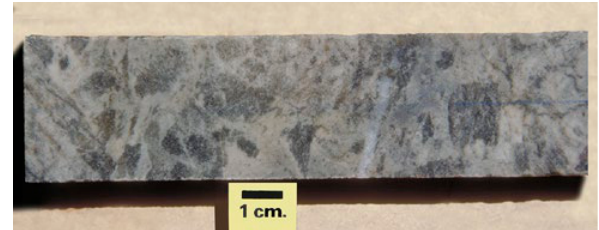
Figure 37. An intrusive siliceous breccia of grey chert contai- ning angular and partly digested fragments of chloritic wall-rock was intersected in drilling near the margins of the gold orebody at the Peak Mine in Cobar, NSW. These earlier grey cherty ‘elvans’ or extensive silicified zones are often found intruded round larger mineral lodes.